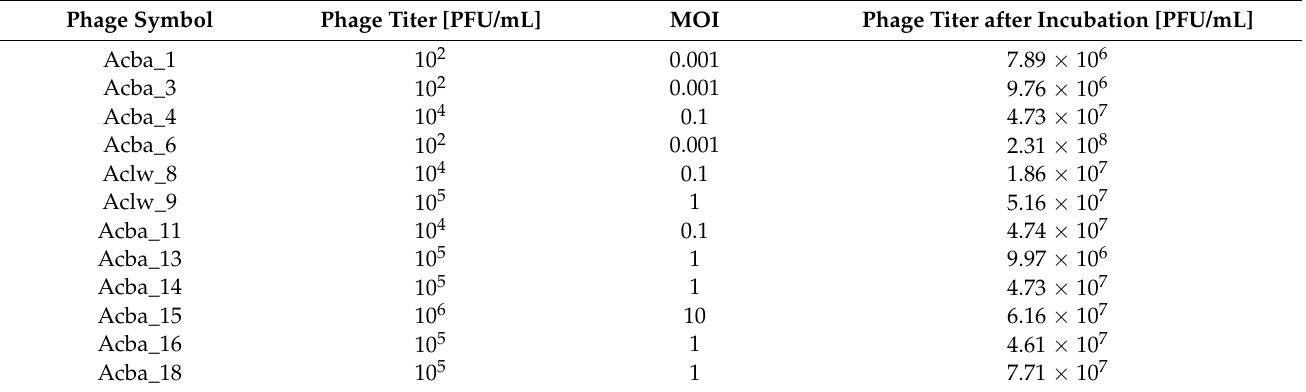
Table 4. MOI values resulting in the highest titer of the tested